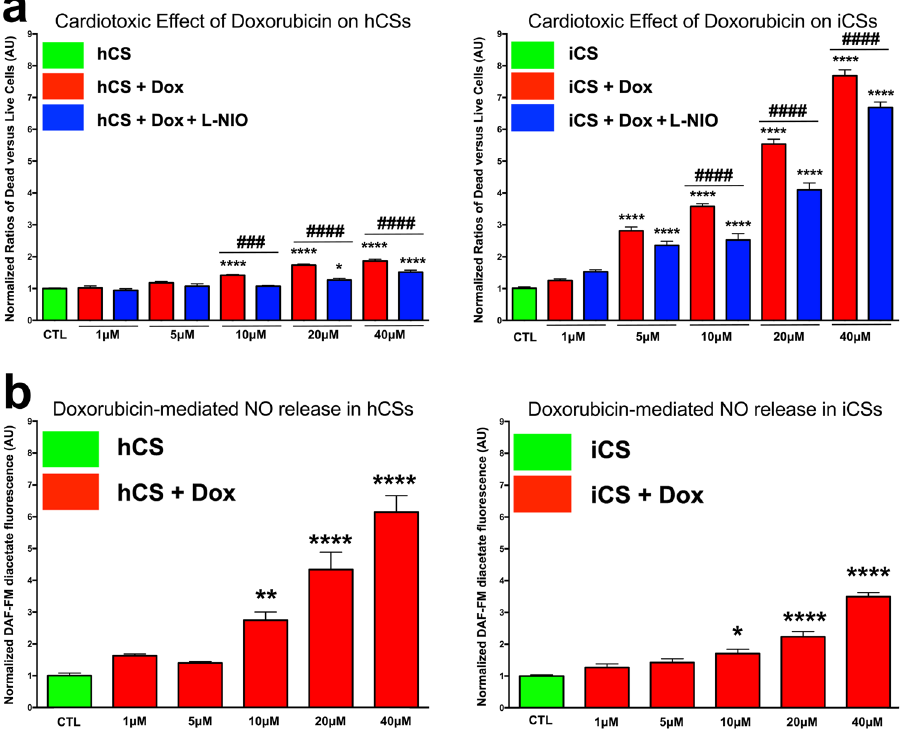
Figure 4. Inhibition of nitric oxide synthesis prevents DOX-mediated cardiotoxic effects in hCSs and iCSs. ( a ) Statistical analysis ( n = 6) of DOX-mediated cardiotoxic effects in hCSs and iCSs evaluated as a ratio between dead and live cells after 24 h treatment. 100 μ M L-NIO prevents the doxorubicin-mediated effects in both hCSs and iCSs treated with 10, 20 and 40 μ M doxorubicin. ( b ) Statistical analysis ( n = 6) of DAF-FM-positive cells in hCSs and iCSs following 24 h doxorubicin treatment. * Relative to control for all groups; ♯ Within the same concentration. Data are presented as mean ± SEM. One-way ANOVA followed by Bonferroni’s multiple comparisons test. F (df 10, 55) = 40.53 for ( a ) hCS, F (df 10, 143) = 253 for ( a ) iCS, F (5, 30) = 37.33 ( b ) hCS and F (5, 30) = 56.09 for ( b ) iCS. See also Fig.